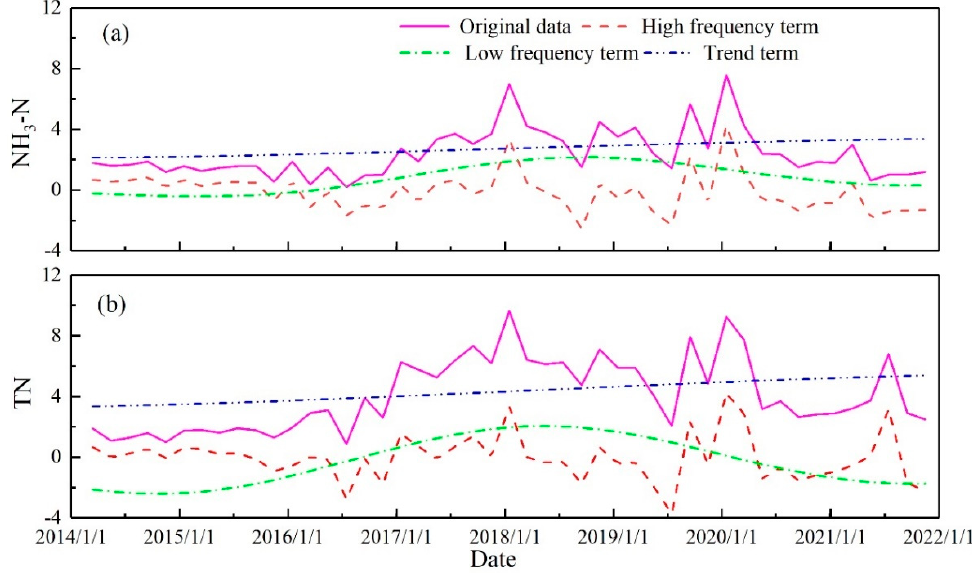
Figure 6. The reclassified terms and the original water quality series. ( a ) NH 3 -N; ( b ) TN.